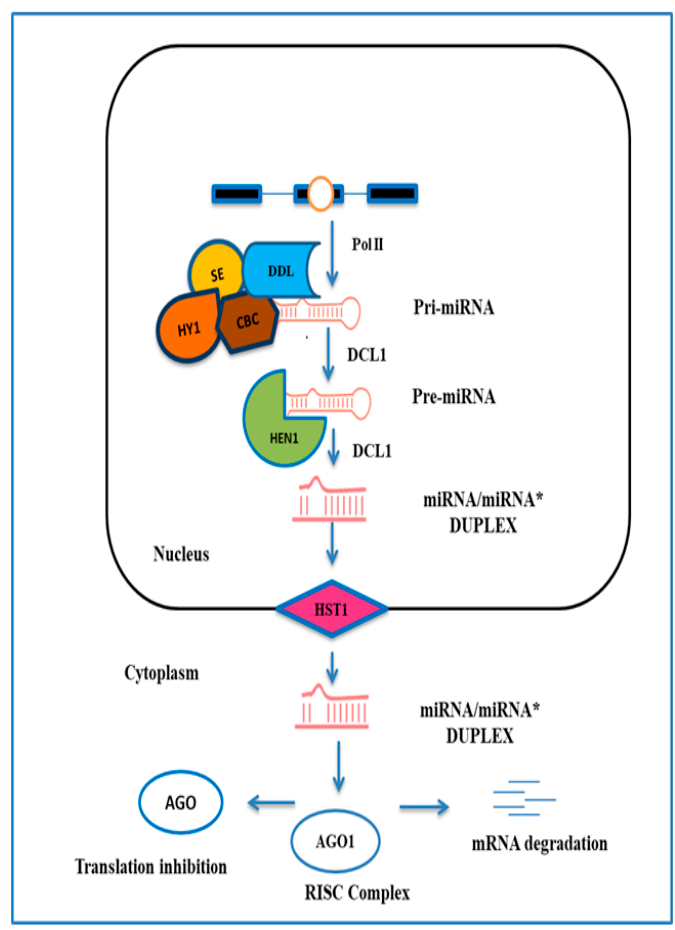
Figure 1. microRNA (MiRNA) biogenesis, miRNA-mediated transcriptional cleavage, and translational inhibition. A simplified model of miRNA biogenesis in plants. The miRNA gene (MIR) is transcribed into a pri-mRNA by RNA polymerase II splicing, and further processing in the nucleus involved the action of homolog of yeast longevity-1 (HYL1), dawdle (DDL), serrate (SE), and Cap-binding proteins. After methylation by the methyltransferase HUA ENHANCER1 (HEN1), the miRNA duplex is exported into the cytoplasm possibly by the HASTY (HST) and the mature miRNA strand is incorporated into an argonaute (AGO) protein.